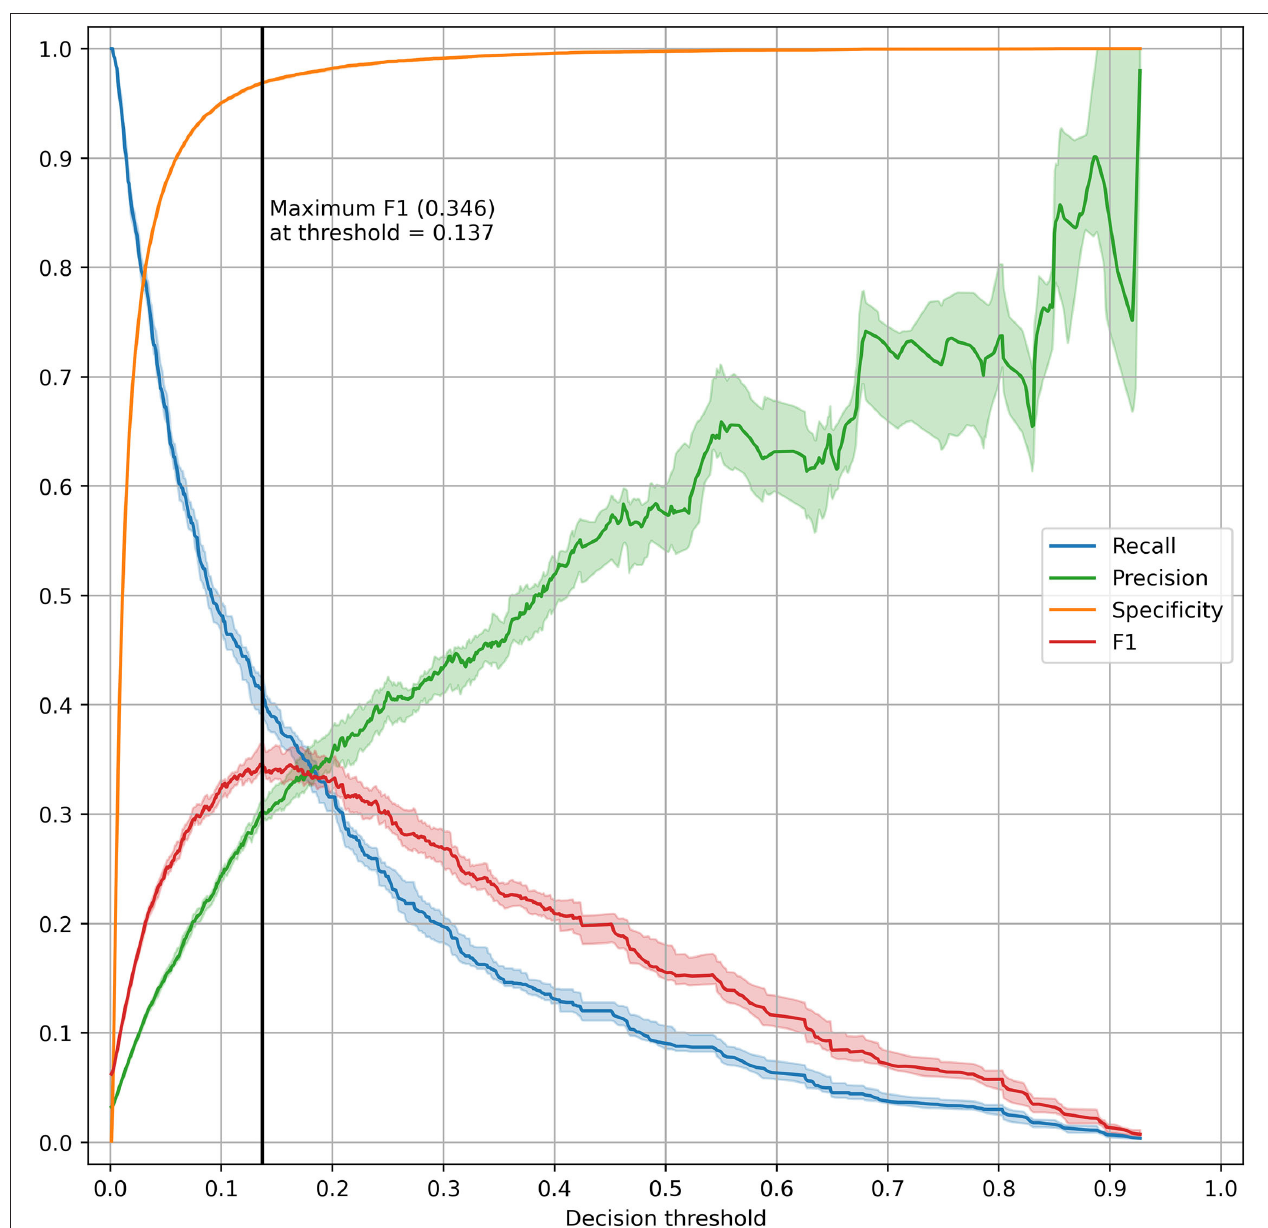
FIGURE 3 | Threshold plot for the optimized XGBoost model. The test set was bootstrapped (full resampling with replacement) 20 times and various performance metrics (recall, precision, specificity, and F1) were plotted against the threshold value. For each metric, the line and shaded area represent the median and IQR. A vertical black line was drawn at the threshold maximizing the F1